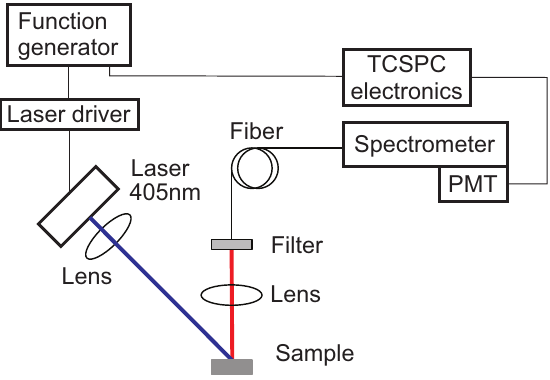
Figure 1. Scheme of the optical experimental setup. Blue is the excitation, red is the luminescence optical path. PMT: